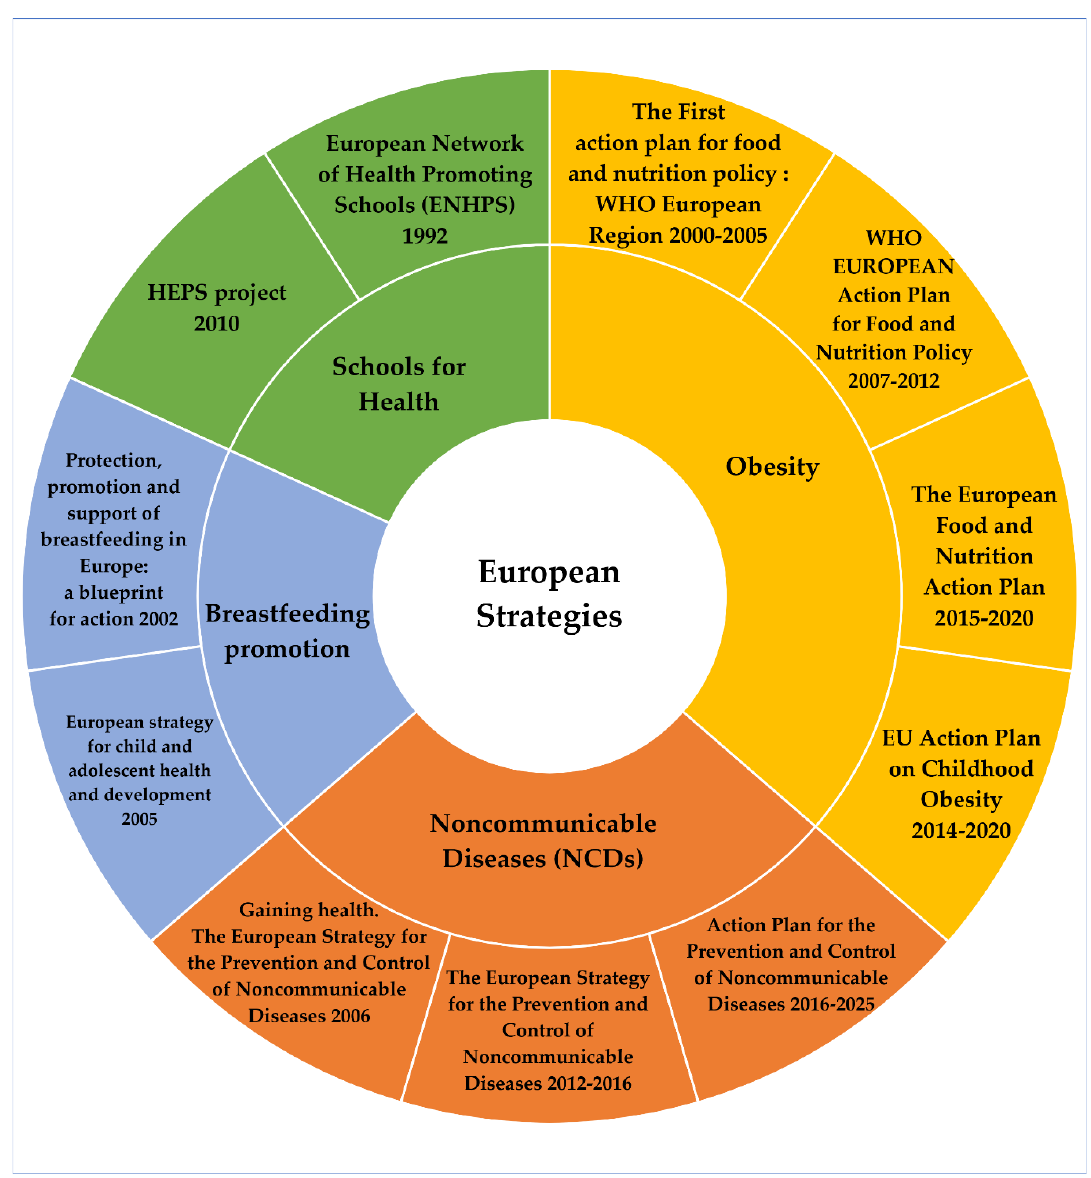
Figure 3. A matrix of nutrition policies targeting children in the European region.